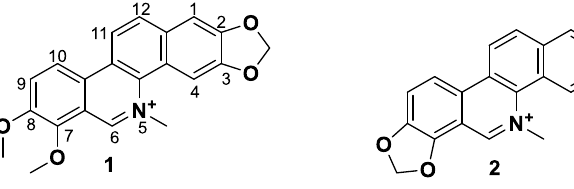
Figure 1. The structures of chelerythrine ( 1 ), sanguinarine ( 2 ), and